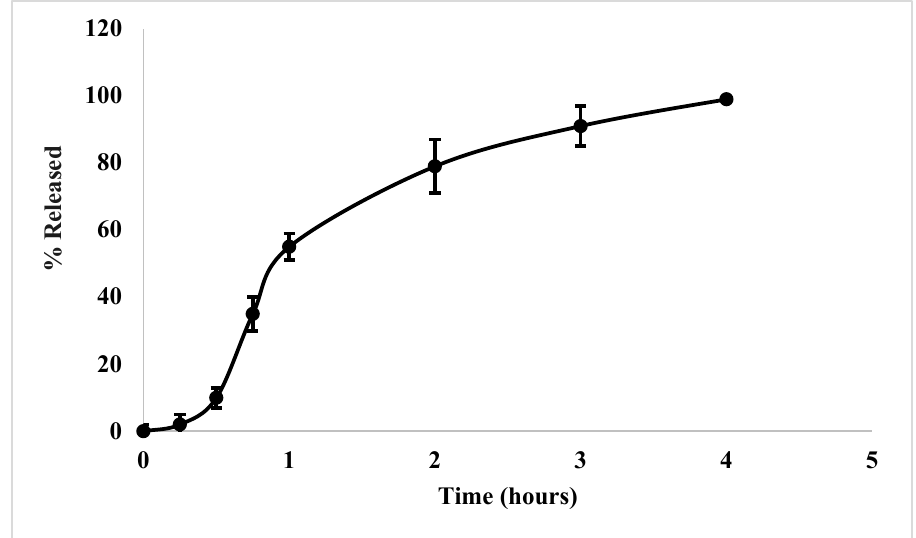
Figure 8. The release profile of PMZ from PMZ/Arg-PA NCs formula F6 over 4 hrs. (mean ± SD, n = 3).